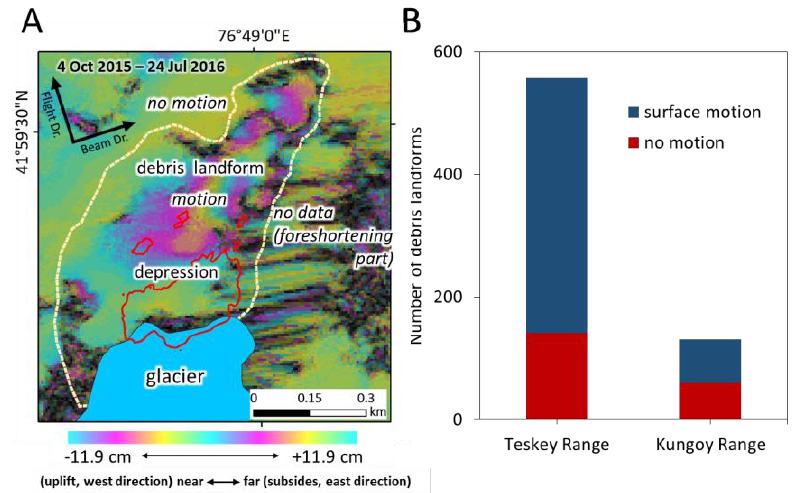
Figure 7. Surface motion around the Jeruy Glacier front. ( A ) Surface displacement map by DInSAR analysis using ALOS-2/PALSAR-2 data. ( B ) The resulting number of debris landforms with and without ground ice (or only little ground ice without significant effect on surface deformation) over the study region.